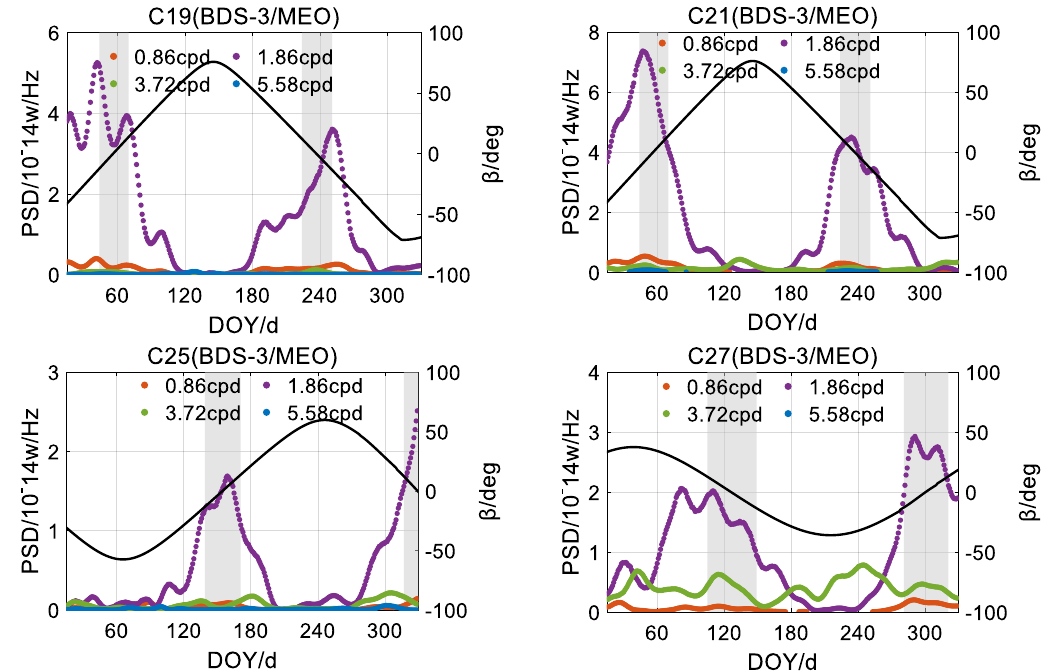
Figure 4. PSD of four significant periodic terms with respect to the β angle.